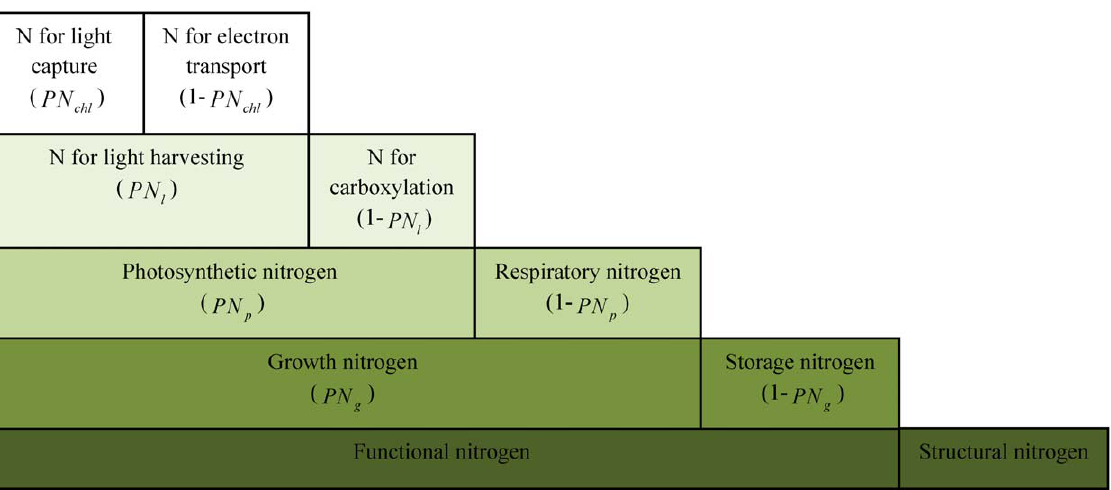
Figure 1. Hierarchical plant functional nitrogen allocation for a leaf layer of a tree. The leaf layer is assigned with a certain amount of plant functional nitrogen ( FNA a ) required to support its growth and maintenance. The required plant functional nitrogen includes the functional nitrogen in leaves as well as the functional nitrogen in roots and sapwood, which is used to acquire water and nutrient for photosynthesis and to provide nitrogen for new tissue synthesis using the photosynthetic products. Structural nitrogen is associated with functional nitrogen to build structural components (DNA and cell walls) in tissues of leaves, sapwood and roots. The available functional nitrogen is first divided into growth nitrogen and storage nitrogen. The growth nitrogen is further divided into photosynthetic nitrogen and respiratory nitrogen, with the photosynthetic nitrogen divided into nitrogen for light harvesting and nitrogen for carboxylation (nitrogen in Calvin Cycle enzymes). Finally, nitrogen allocated for light harvesting is divided into nitrogen for light capture (nitrogen in proteins of phosystems I, II and chlorophyll a/b complexes) and nitrogen for electron transport (nitrogen in proteins of thylakoid bioenergetics). The parameter in the parenthesis indicates the proportion of nitrogen invested for its category in the same row.